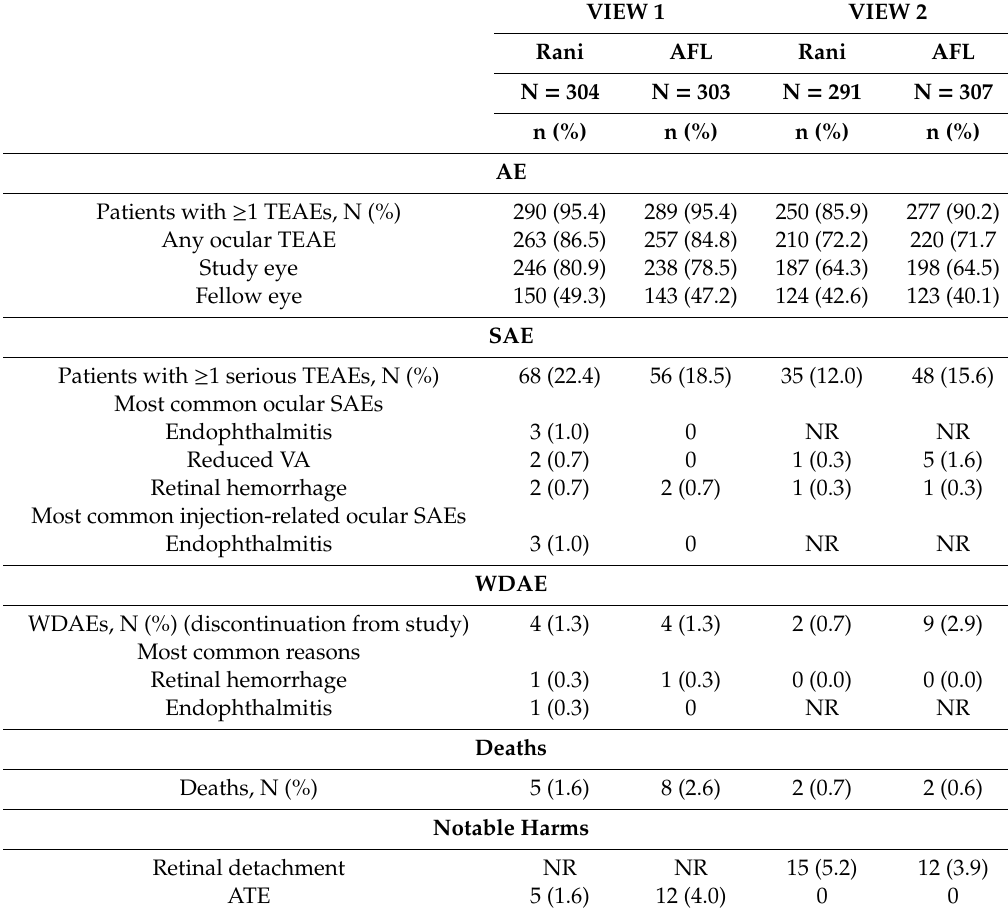
Table 6. An overview of the adverse events reported in the VIEW 1 and VIEW 2 studies. Adapted from Heier et al. [120] and Schmidt-Erfurth U et al.